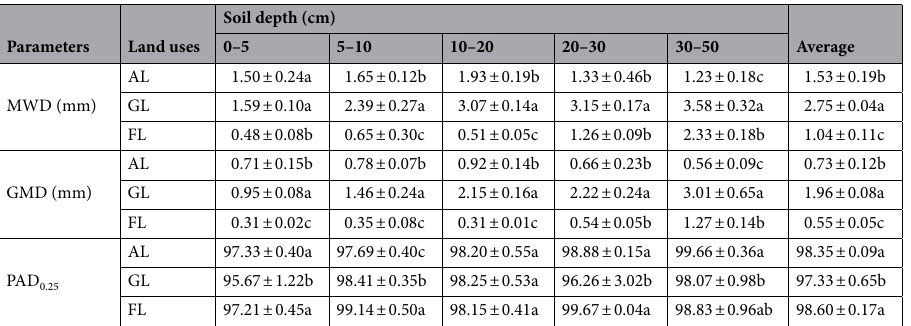
Table 3. MWD, GMD values and PAD 0.25 of soil dry stable aggregates for different land uses (mean ± SD). Different letters with the same soil depth indicate significant difference (n = 5, p < 0.05) among different land uses by one-way ANOVA. MWD the mean weight diameter of dry stable aggregates, GMD the geometric mean diameter of dry stable aggregates, PAD 0.25 the > 0.25 mm percentage of aggregate disruption.